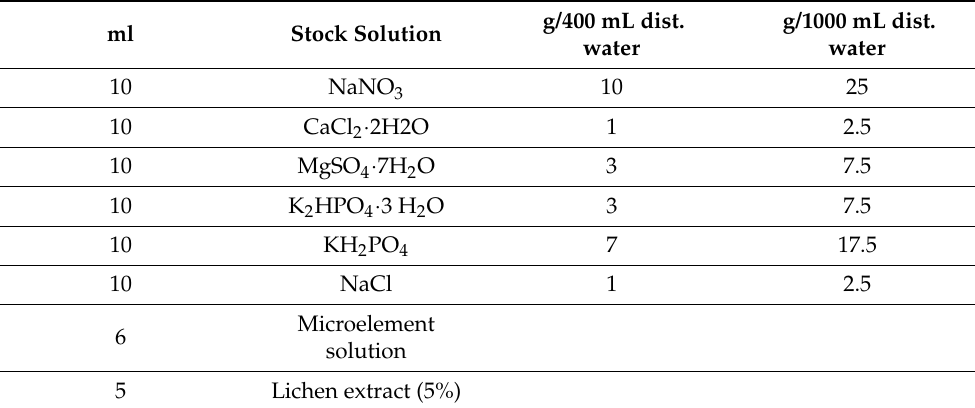
Table A1. General purpose freshwater medium used for lichen axenic cultures. Preparation: To 940 mL of de-ionized or distilled water, add.